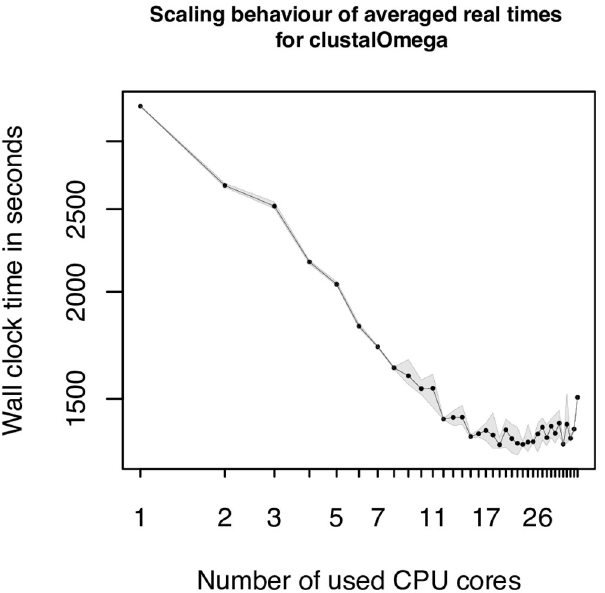
Fig 7. Scaling plot for larger Clustal Omega dataset. Additional scaling plot showing the scaling behavior of Clustal Omega, using the full ANCA.1 dataset. The x-axis represents the number of used cores, where the y-axis illustrates the measured wall-time in seconds. Due to the logarithmic x and y axes, a linear scaling performance can be made visible. The borders of the gray area show the measured minimal and maximal wall-times from the multiple replicas.